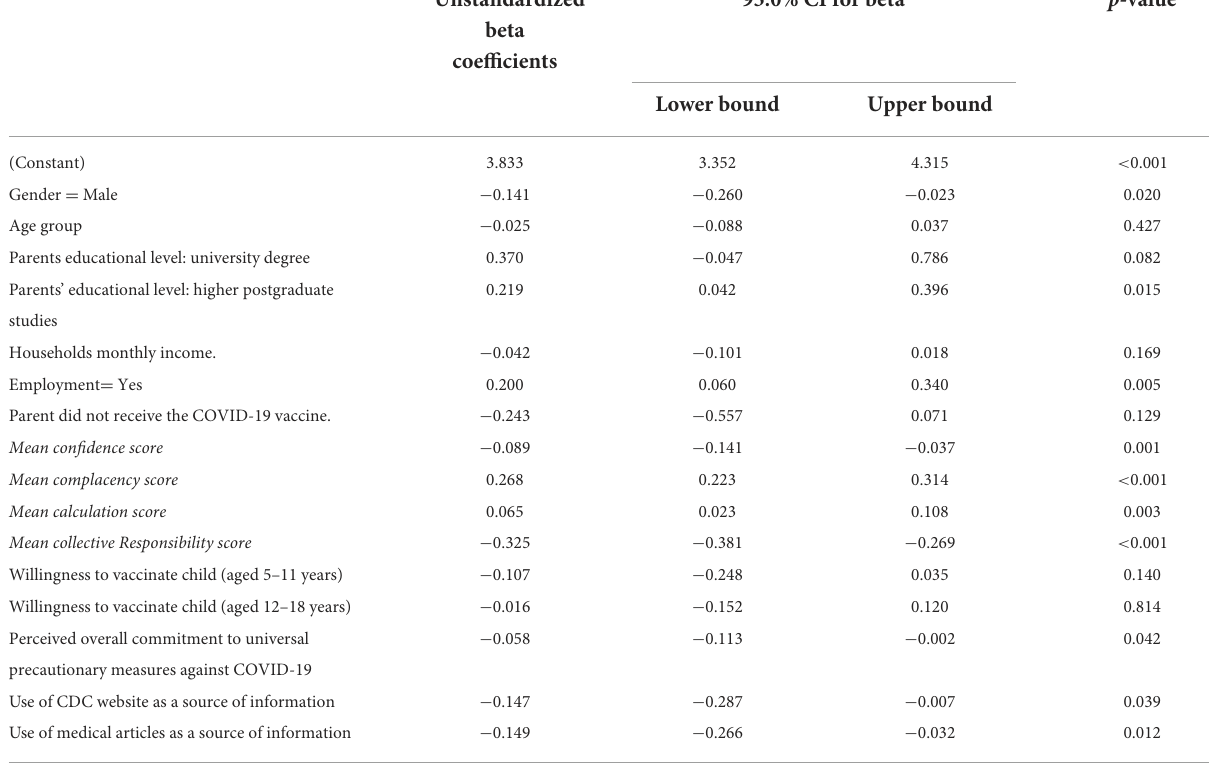
TABLE 3 Multivariate linear regression analysis of parents’ constraints as scored by the 5C